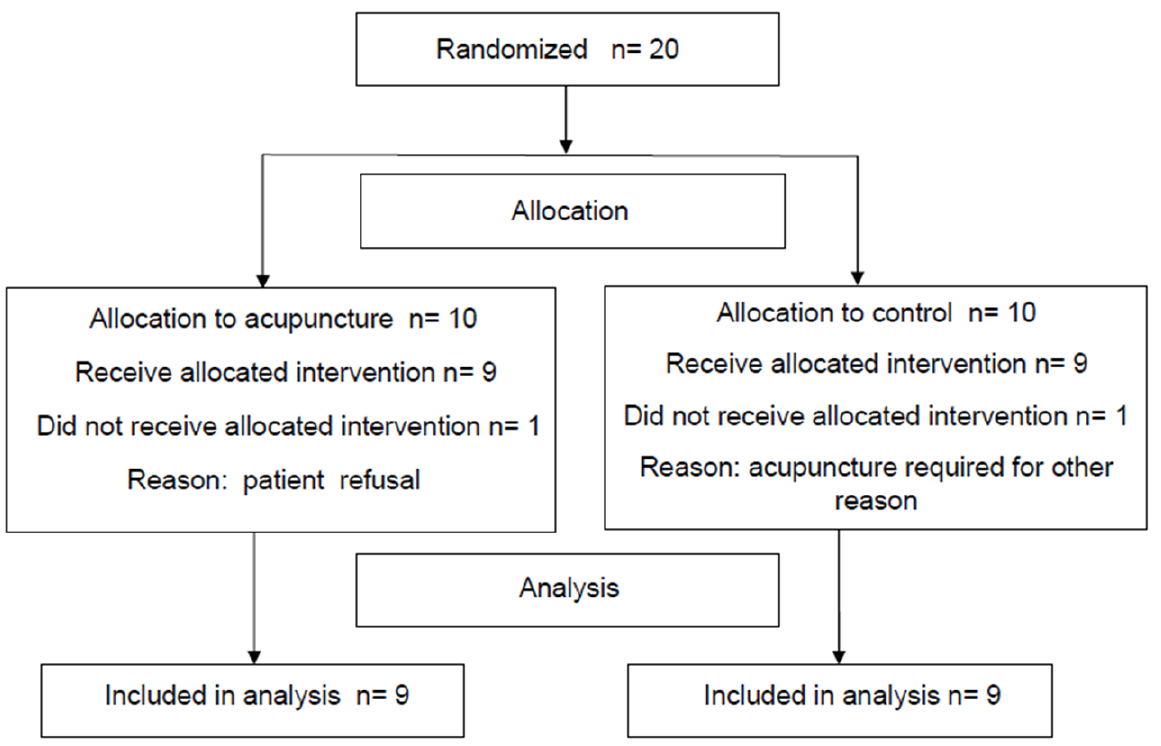
Figure 2. Flow chart.